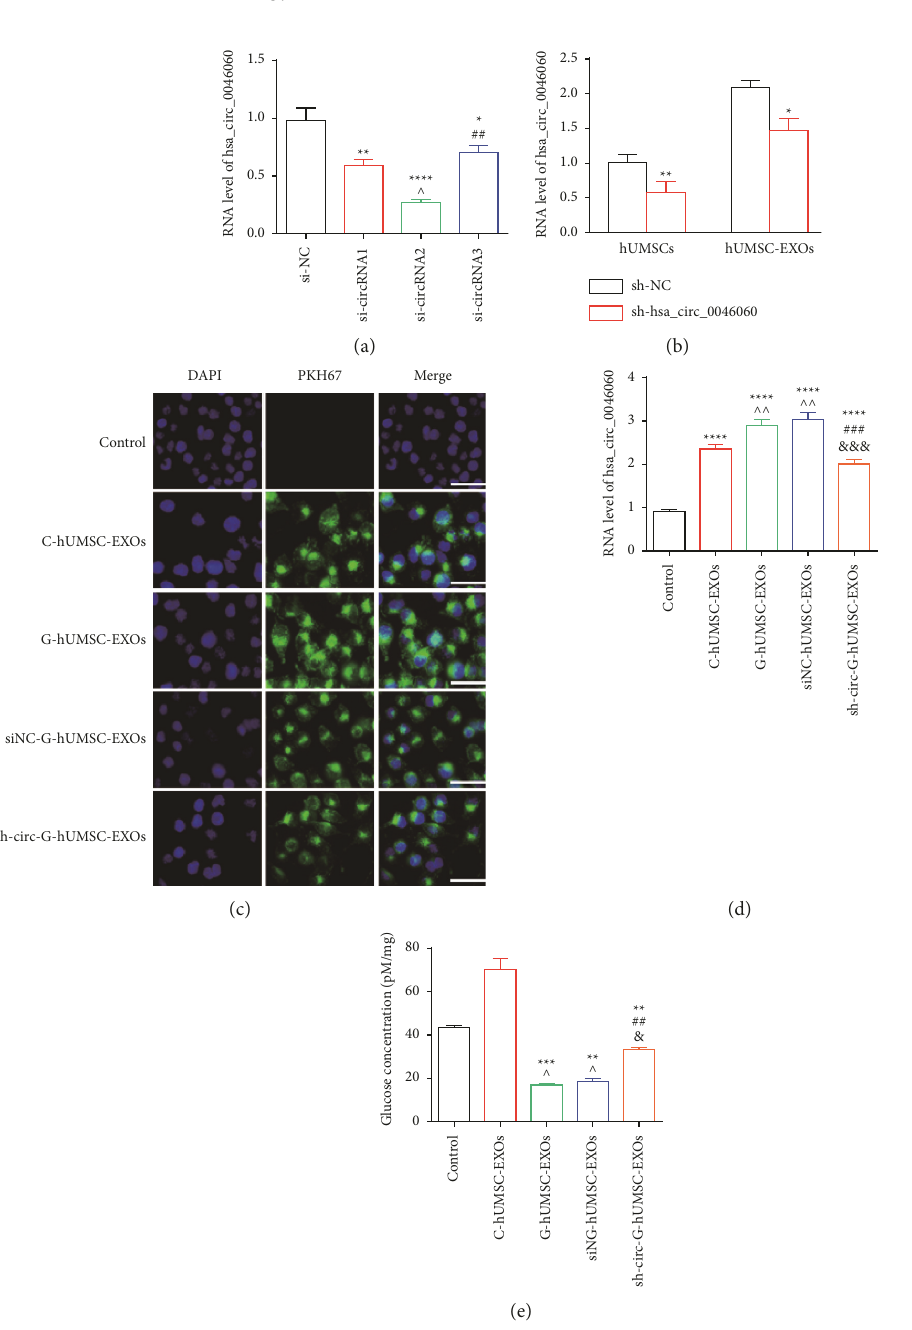
Figure 2: Hsa_circ_0046060 inhibition reversed the effect of GDM-derived hUMSC exosome on intracellular glucose concentration. (a) Inhibitory effects of three candidate siRNAs targeting hsa_circ_0046060 as determined by RT-qPCR PKH67 labeled exosomes into L-02 cells after 24 h treatment. Scale bar 20 μ m. (d) Levels of hsa_circ_0046060 were determined using RT- (cid:31) qPCR after treatment with different huMSC-EXOs